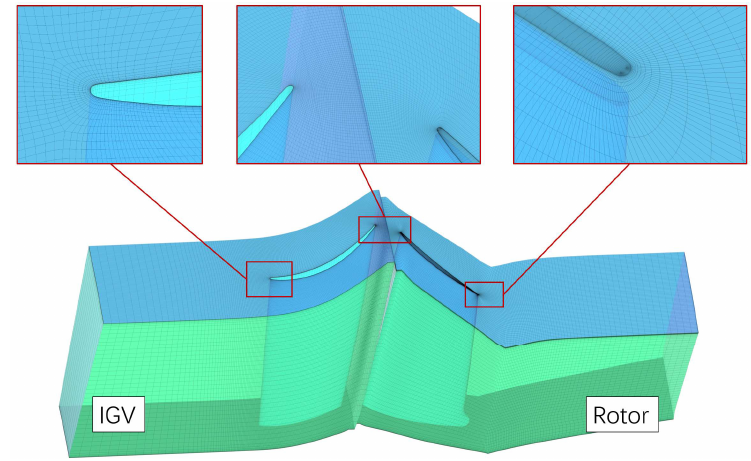
Figure 2. The computational grid of the compressor used in this study.